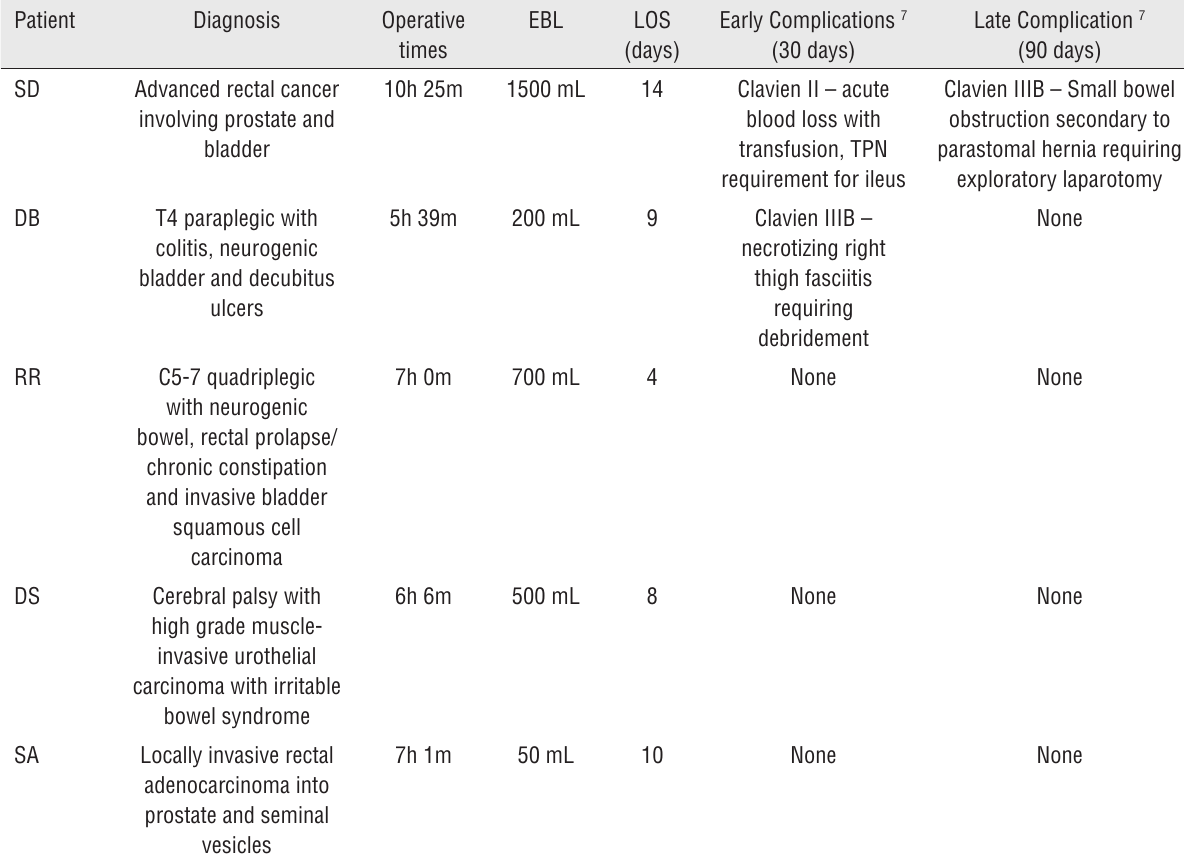
Table 1 - Case details for five cases with urinary diversions using colonic conduits.